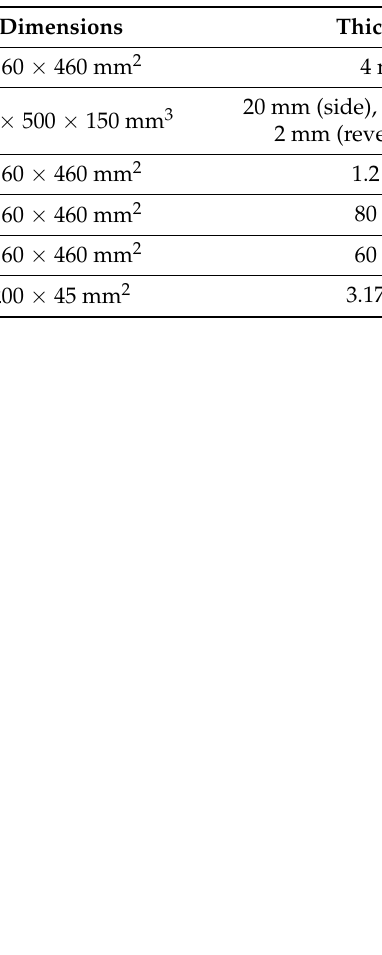
Table 2. Geometrical details of material used for construction of solar collector.